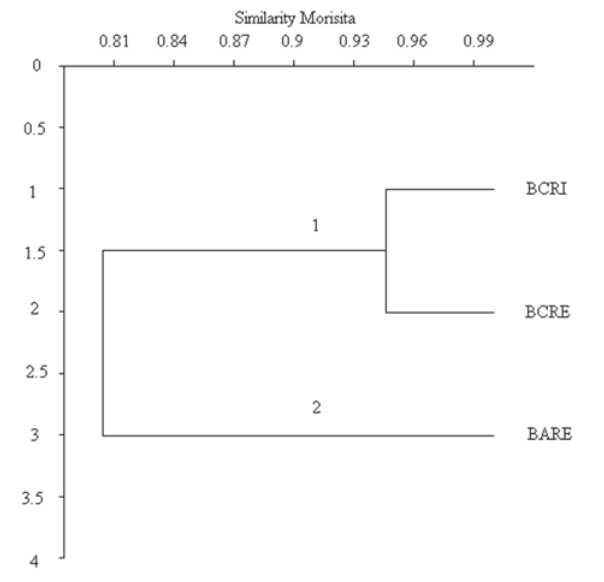
Fig. 1. Diet similarity based on food items found in stomachs of Bryconops (BC = B. caudomaculatus , BA = B. alburnoides ; RE = reservoir; RI = river; 1 = ingestion predominantly com- posed of terrestrial insects; 2 = ingestion predominantly com- posed of immature